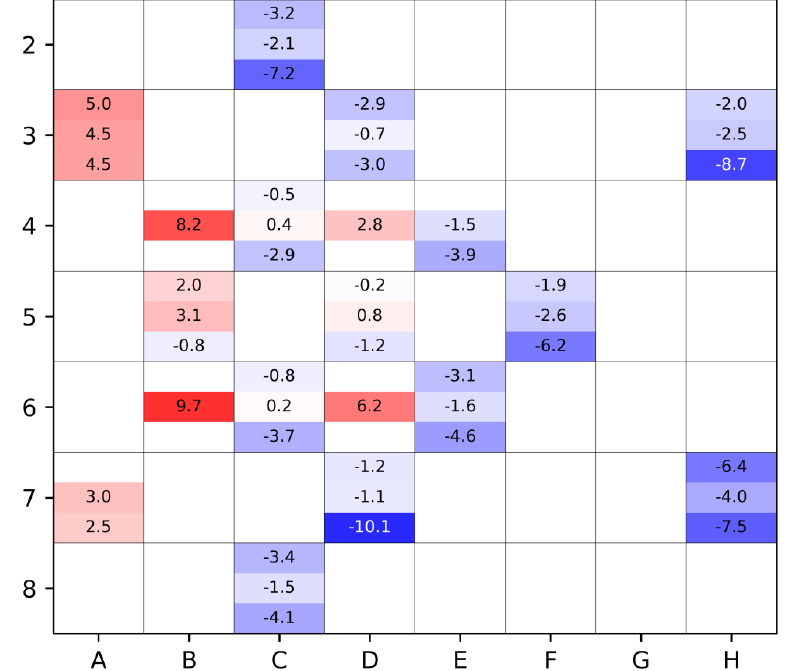
Figure 7. Relative differences in the calculated and experimental Cu-63 reaction rates for cycle 2018-08 (C/E-1, in %). Results are integrated between ±28 cm with respect to core center